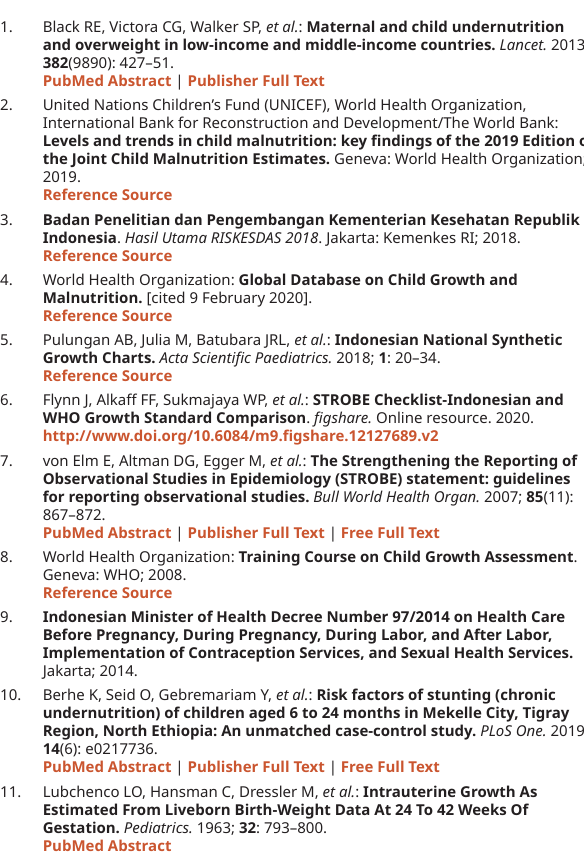
Figshare: Growth standard comparison between WHO